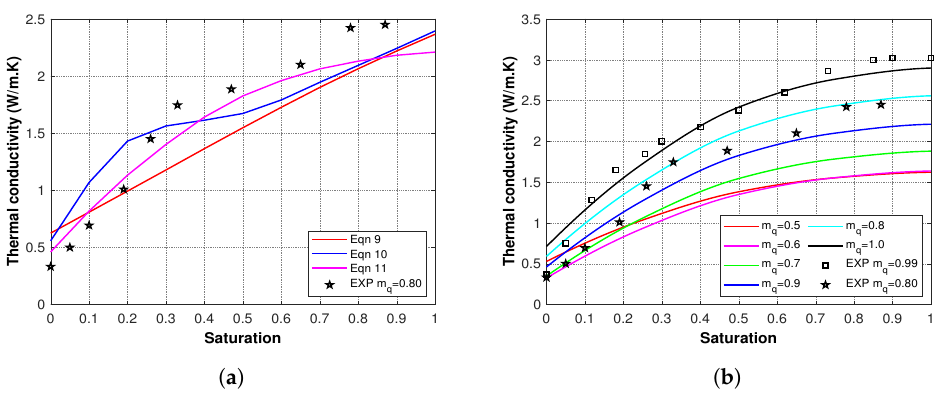
Figure 10. Thermal conductivity predection based on GEP. ( a ) Thermal conductivity estimation from Equations (12)–(14) plotted against experiment result for m q of 0.8 ( b ) with values of m q ranging between 0.5–1.0 in Equation (14) and experiment result of m q 0.8 and 0.99 of two different